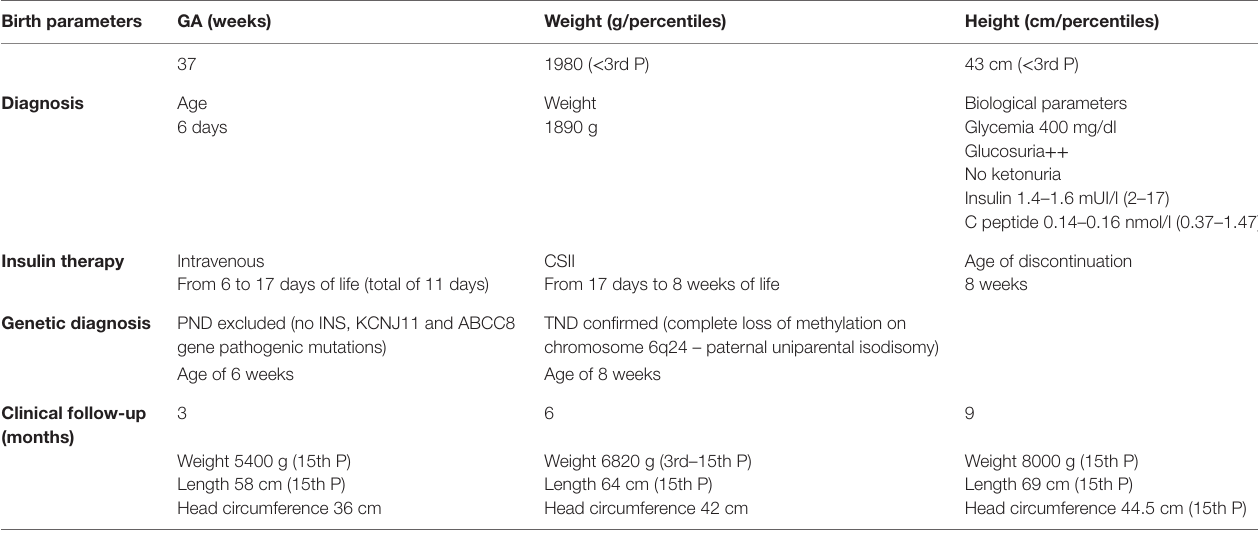
taBLe 1 | Newborn data